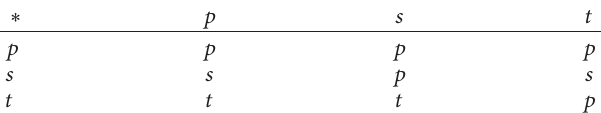
Table 9: Cayley table of the binary operation ∗ .